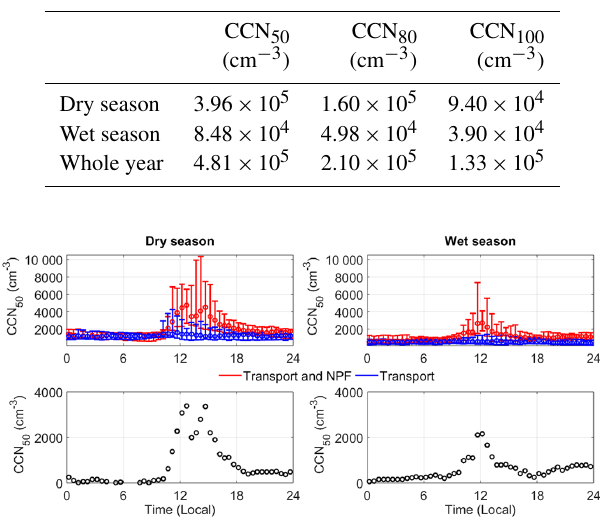
Figure 3. Median diurnal variation of CCN 50 on event (upper panel, red line) and non-event days (upper panel, blue line). CCN 50 at- tributed to NPF (lower panel) is calculated as the difference of the concentrations recorded on event and non-event days. Lower and upper limits of the error bars stand for the 1st and 3rd quartiles,